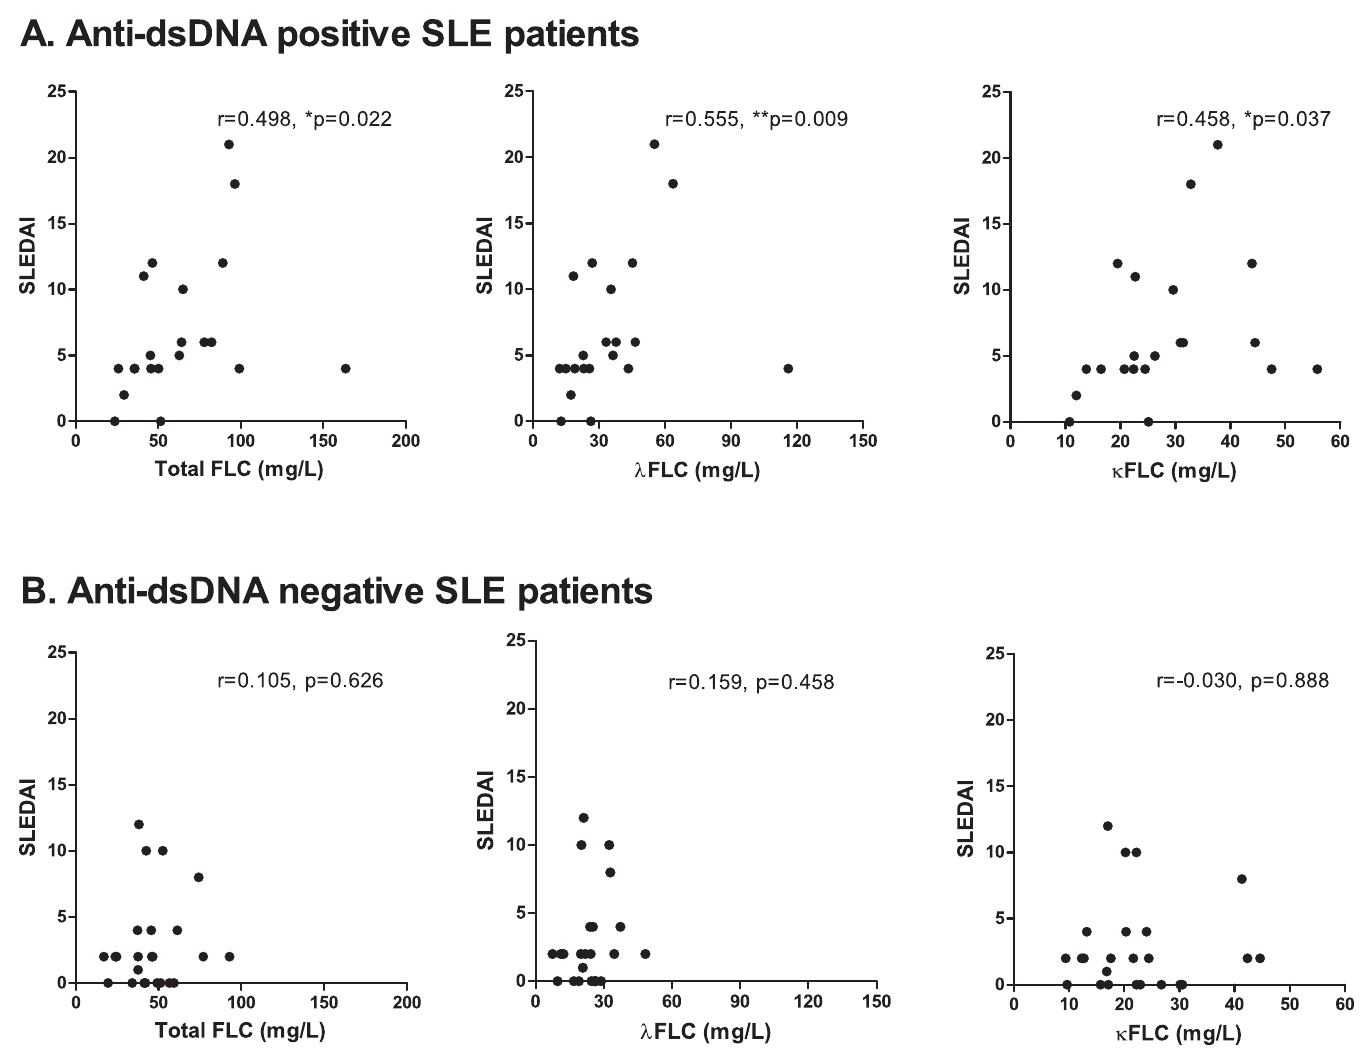
Fig 4. Correlation between serum FLC concentrations and SLEDAI scores in anti-dsDNA positive SLE patients. Correlation between SLEDAI scores and total FLC, λ FLC and κ FLC levels in anti-dsDNA positive SLE patients (A) (n = 21) and in anti-dsDNA negative SLE patients (B) (n = 24). A: Anti-dsDNA positive SLE patients . r-values are 0.498 (p = 0.022), 0.555 (p = 0.009) and 0.458 (p = 0.037) regarding total FLC, λ FLC and κ FLC levels, respectively. B: Anti-dsDNA negative SLE patients . r-values are 0.105 (p = 0.626), 0.159 (p = 0.458) and 0.030 (p = 0.888) regarding total FLC, λ FLC and κ FLC levels, respectively. FLCs — free light chains, SLE — systemic lupus erythematosus, SLEDAI — SLE disease activity index.